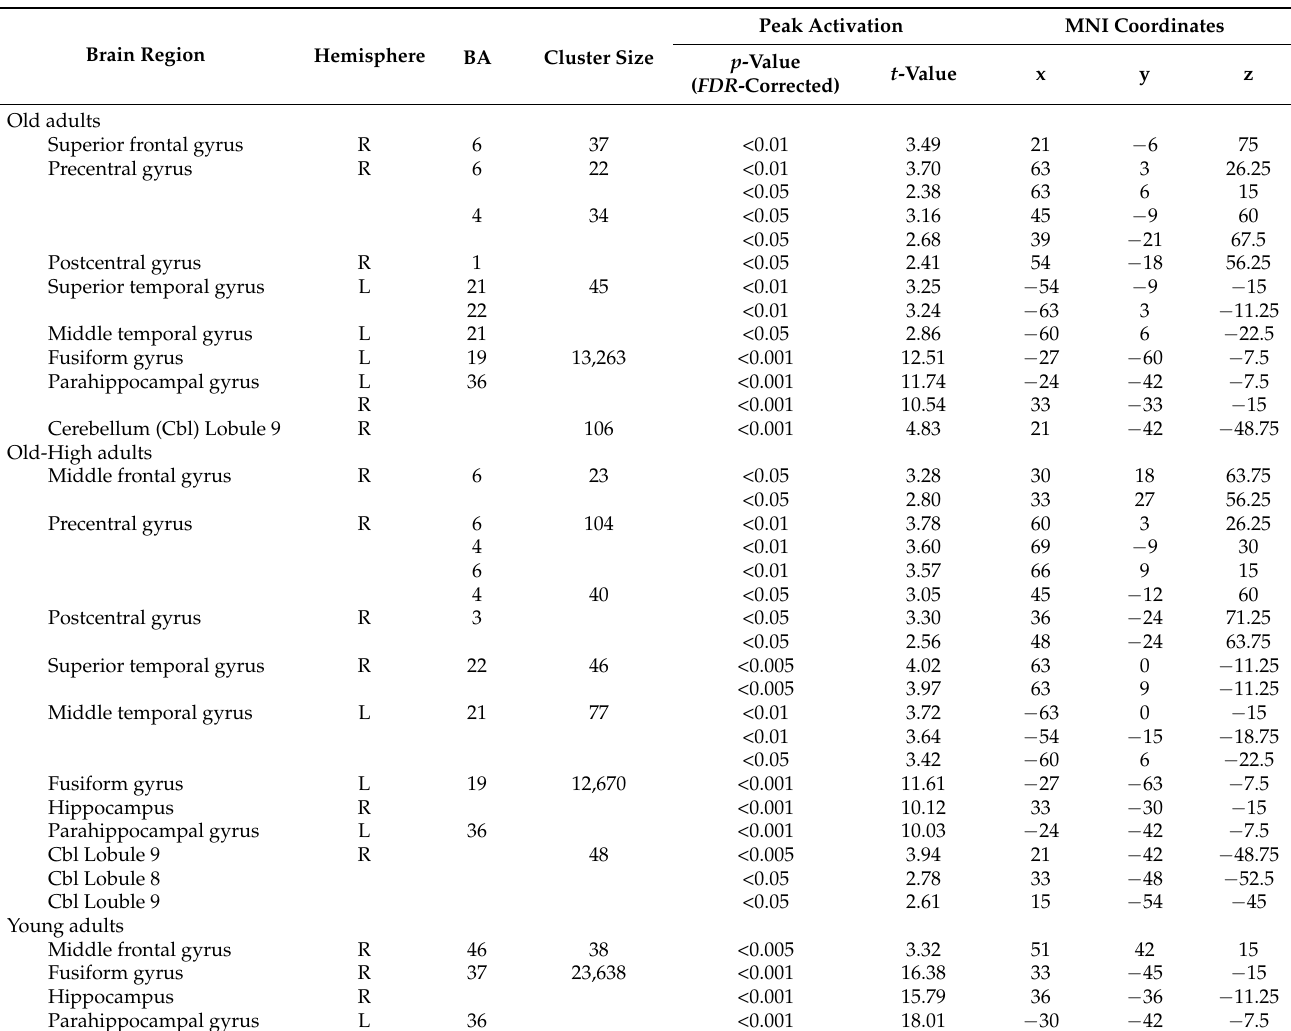
Table 1. Significant cluster-level activations for novelty encoding of scenes (N > R contrast), at p < 0.05 ( FDR -corrected) with k ≥